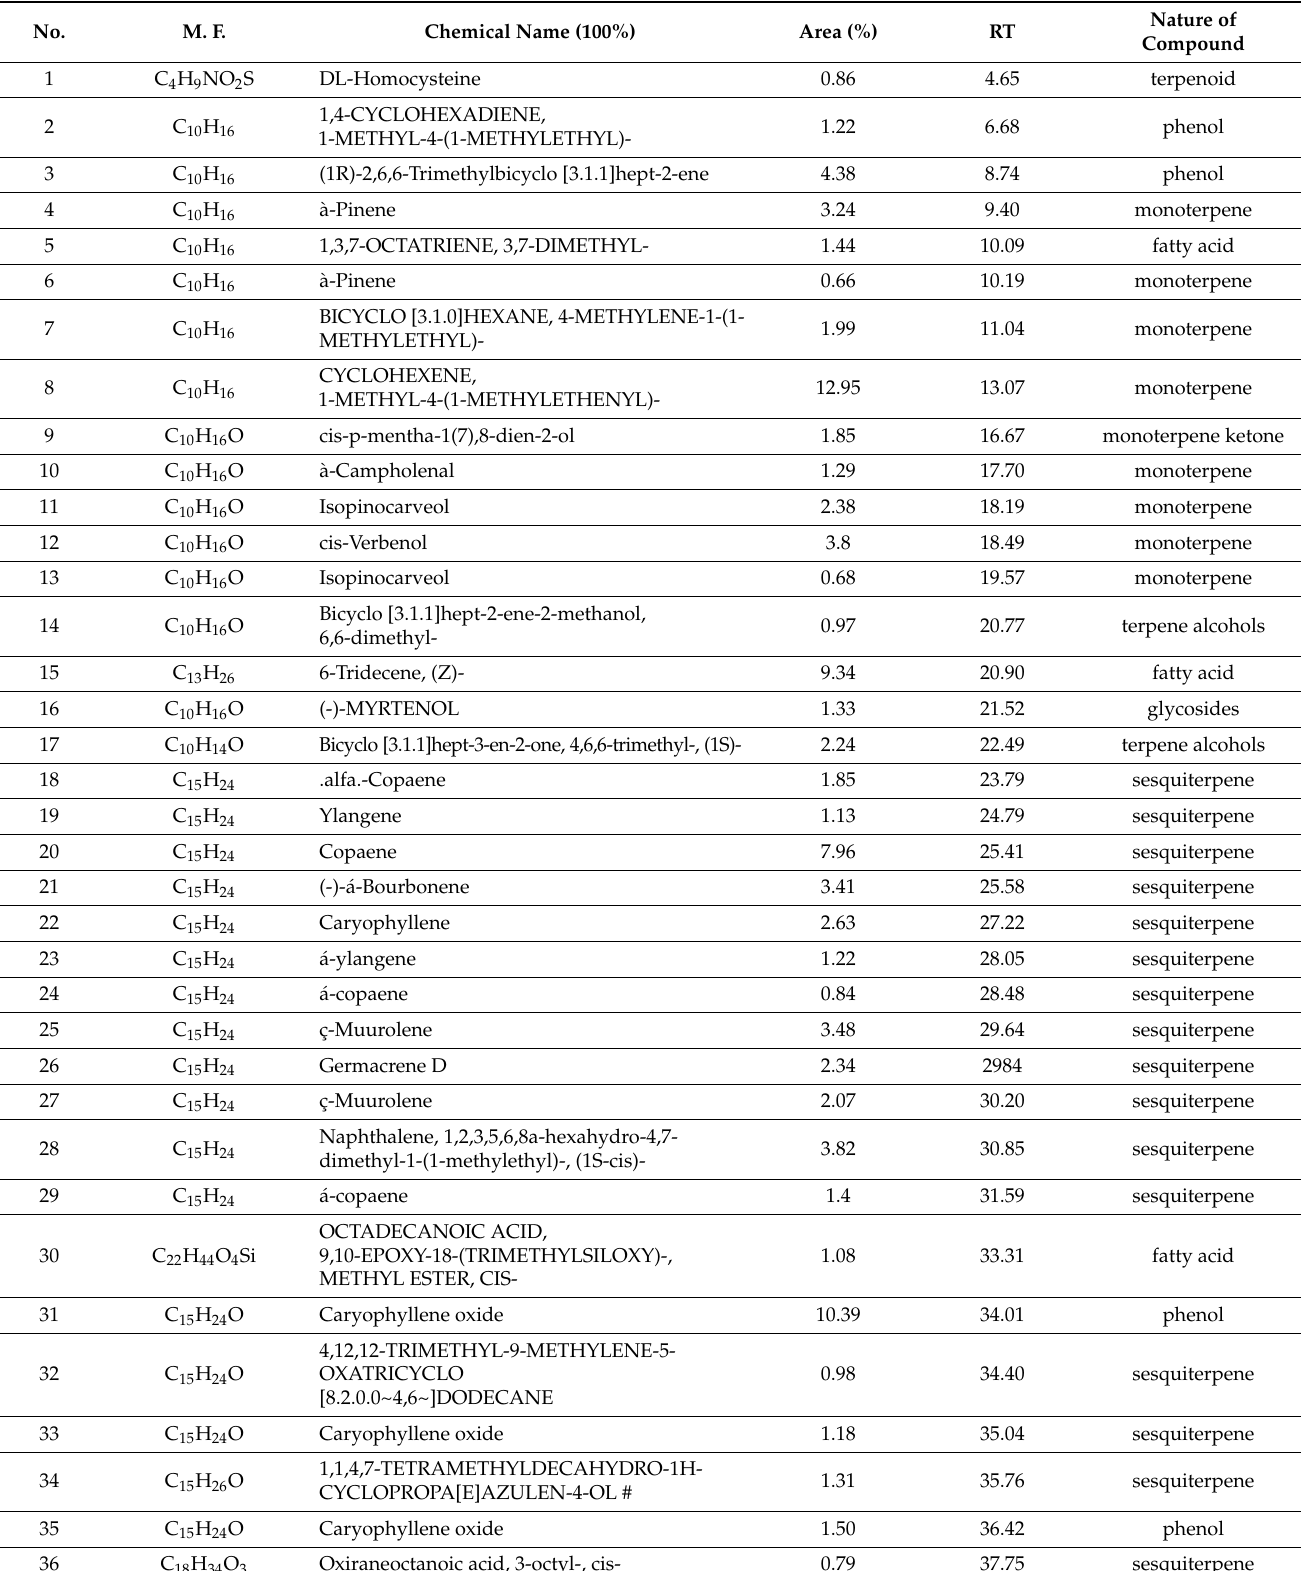
Table 11. The major chemical constituents of Araucaria heterophylla methanol